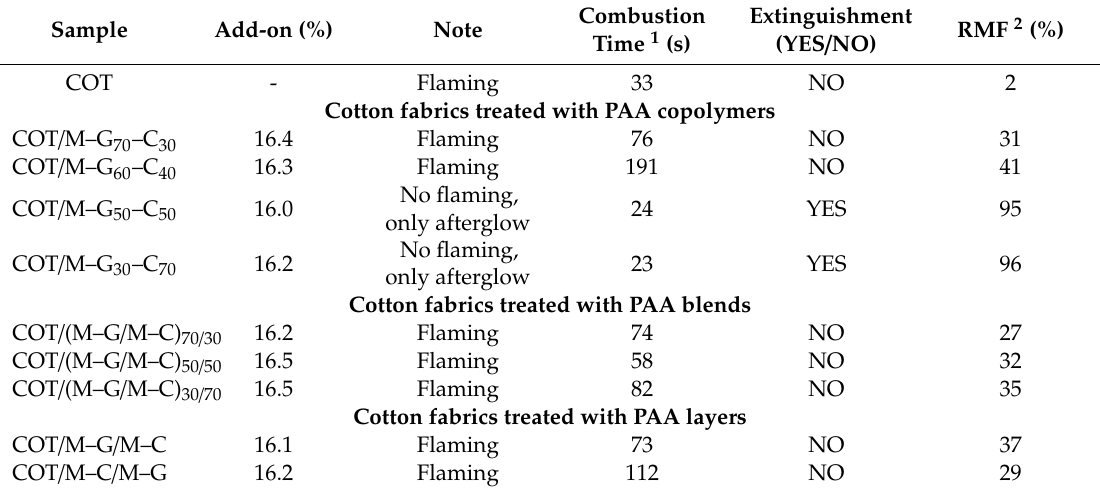
Table 5. Combustion data of untreated and PAA-treated cotton fabrics from vertical flame spread tests.